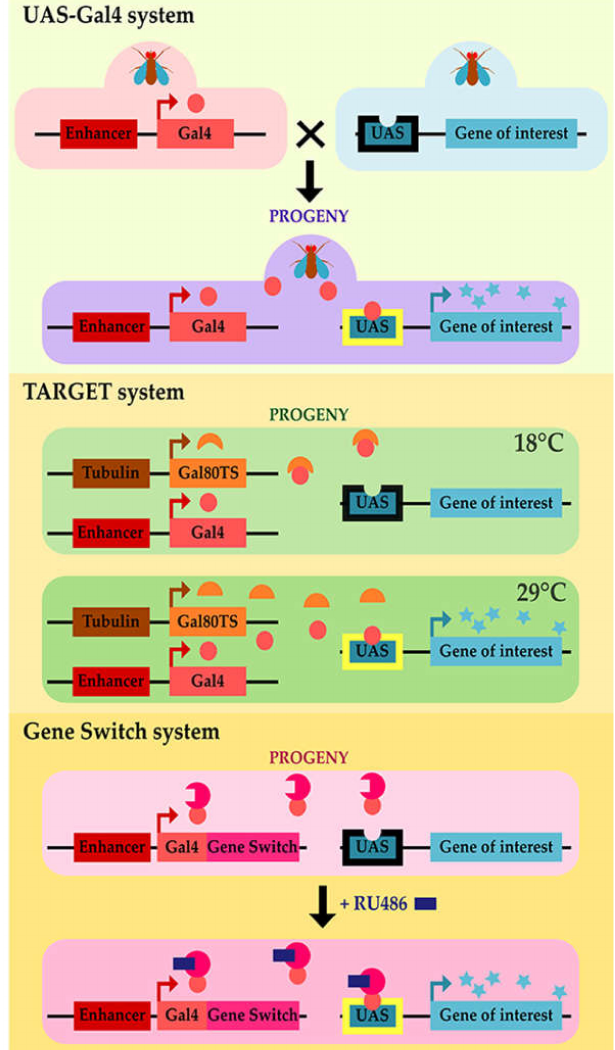
Figure 1. Drosophila genetic tools. The Gal4 system introduced in Drosophila allows transgene ectopic expression with spatiotemporal control. The upstream activating sequence (UAS)/Gal4 is a bipartite system. One transgenic line expresses the Gal4 transcription factor from yeast in a tissue-specific manner using an endogenous promoter or an enhancer sequence. The other line carries the transgene under the control of the UAS (upstream activating sequence). In the progeny of the cross, the UAS is bound by Gal4 protein and the transcription of the gene of interest starts. The temporal and regional gene expression targeting (TARGET) method allows a more flexible temporal control of the Gal4 system. A temperature-sensitive version of Gal80 protein (Gal80TS) is expressed ubiquitously under the control of the Tubulin promoter. At permissive temperature (18 ◦ C), Gal80TS bound to Gal4 and prevents the starting of the transcription. A temperature shift to 29 ◦ C relieves the transcriptional repression and permits the transcription of the gene of interest. The GeneSwitch system is based on hormone-inducible Gal4 and allows a temporal regulation of transgene expression. Gal4 is fused to a progesterone receptor, and the addition of hormone or synthetic ligand (RU486) in the feeding of the fly (adults or larvae) activates the transcription of the gene of interest. This system is reversible as the removal of ligand silent the system. All these genetic tools are routinely used in laboratory to precisely control transgenes expression not only in a specific tissue but also in a precise temporal